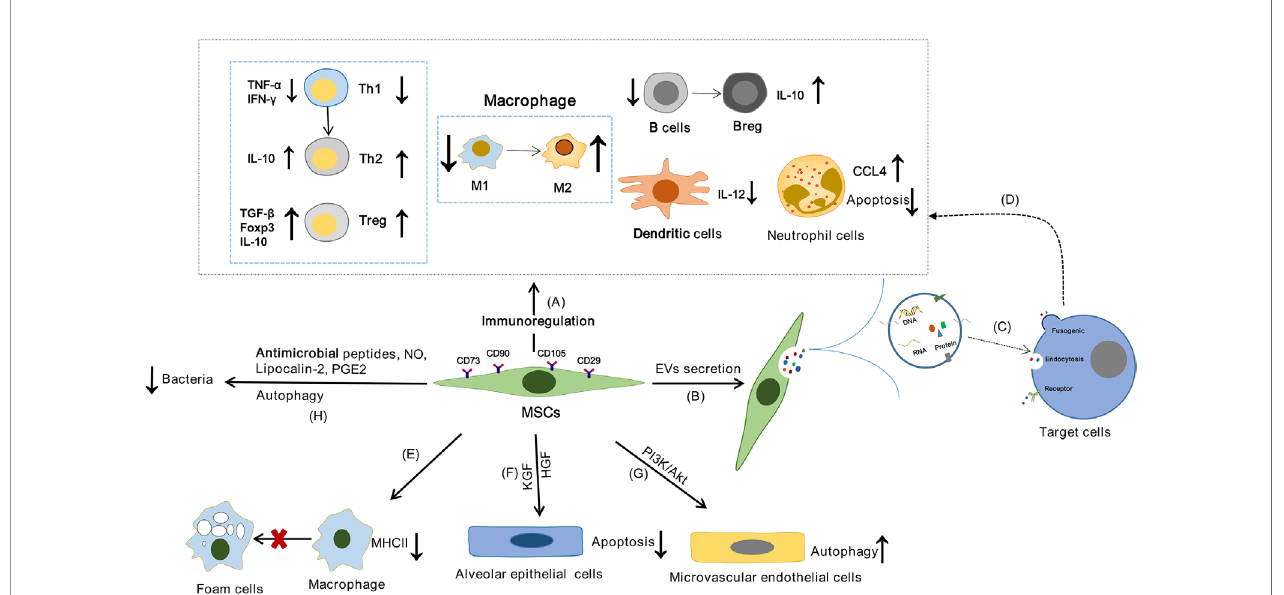
FIGURE 2 | The possible mechanism of MSCs in the treatment of TB. MSCs may achieve the purpose of treating TB by regulating the in fl ammatory response of TB, alleviating the lung injury of TB, affecting the survival of host cells and clearing bacteria. (A) The functions of innate immune cells and adaptive immune cells can be effectively regulated by MSCs through “ direct interaction between cells ” , secreting enzymes and cytokines. (B) EVs secreted by MSCs are lipid vesicles that mediate intercellular communication. (C) EVs can be used as antigen to bind to the target cells, or as a carrier to deliver proteins, DNA, mRNA and non-coding RNA to the target cells. (D) The function of immune cells can be regulated by MSCs through the release of EVs. (E) Macrophages can differentiate into foam cells, which are characterized by lipid accumulation. And MSCs can affect the lipid homeostasis of macrophages, inhibit the formation of foam cells, and reduce the expression of MHCII in macrophages, thereby reducing the uptake of oxidized low density lipoprotein. (F) KGF and HGF secreted by MSCs protect alveolar epithelial cell from apoptosis under hypoxic conditions. (G) MSCs can enhance pulmonary microvascular endothelial cell autophagy through PI3K/Akt signal transduction. (H) MSCs exhibited antimicrobial activity by secreting antimicrobial peptides and NO, enhancing the activity of lipoprotein-2, and enhanced